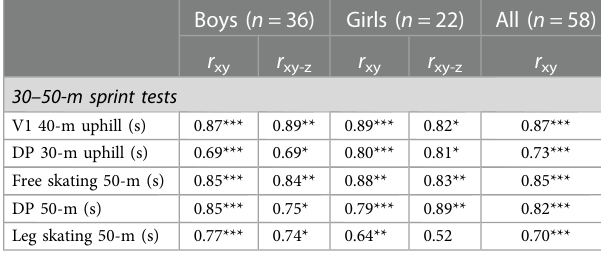
TABLE 4 Bonferroni – Holm adjusted correlations ( r xy ) and partial correlations ( r xy-z : maturity offset as a confounder) between XC skiing test performance (seconds) and P XC